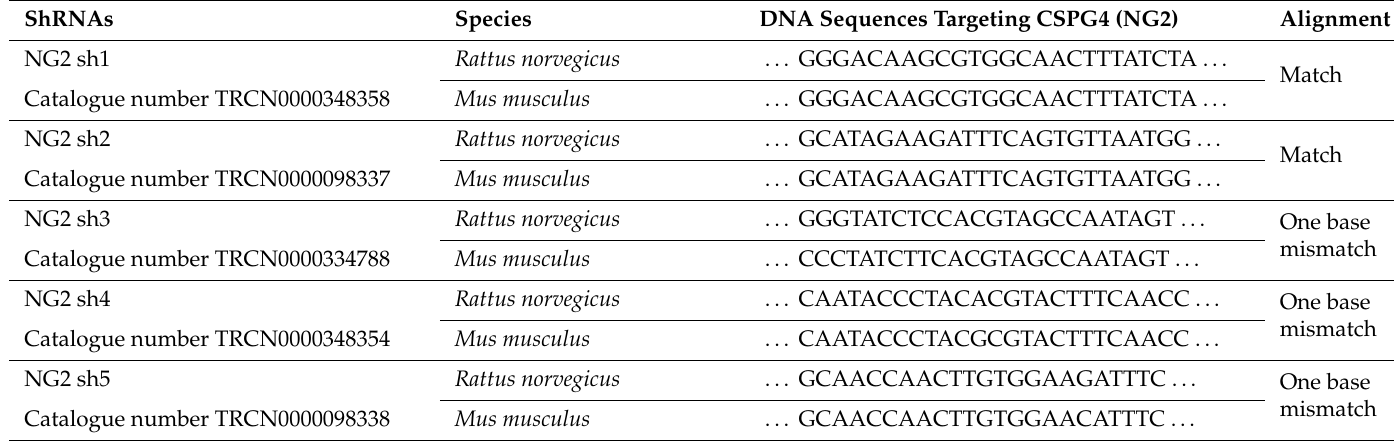
Table 1. Summary of sequence alignment of shRNA targeting NG2 between Rattus norvegicus and Mus musculus . The mismatched base pairs between two species are shown in cyan as shown in NG2 sh3, sh4 and sh5. Key: sh: short hairpin RNA; CSPG4: chondroitin sulphate proteoglycans